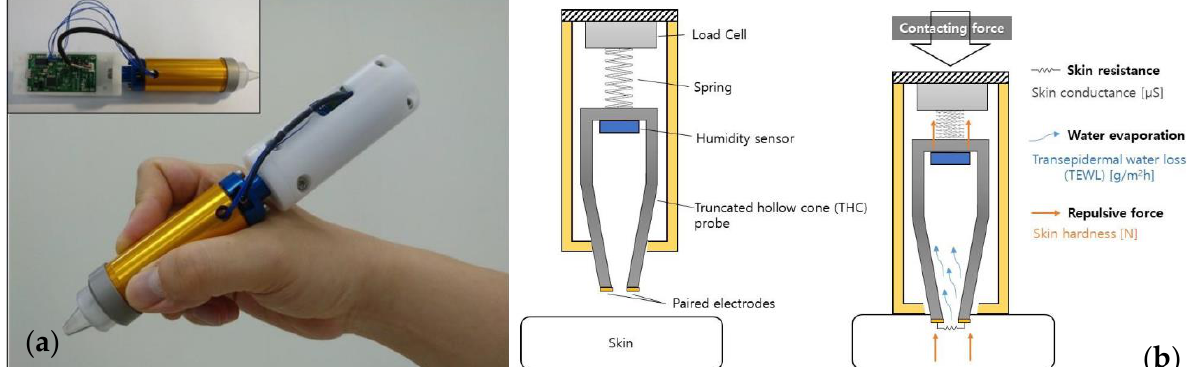
Figure 4. Images of multimodal device for measurement of TEWL, skin conductance and skin hardness constructed by Sim et al. A photograph is visible in ( a ) (left) and in ( b ) (right), its operating principle is presented. Images reproduced with permission from [50].